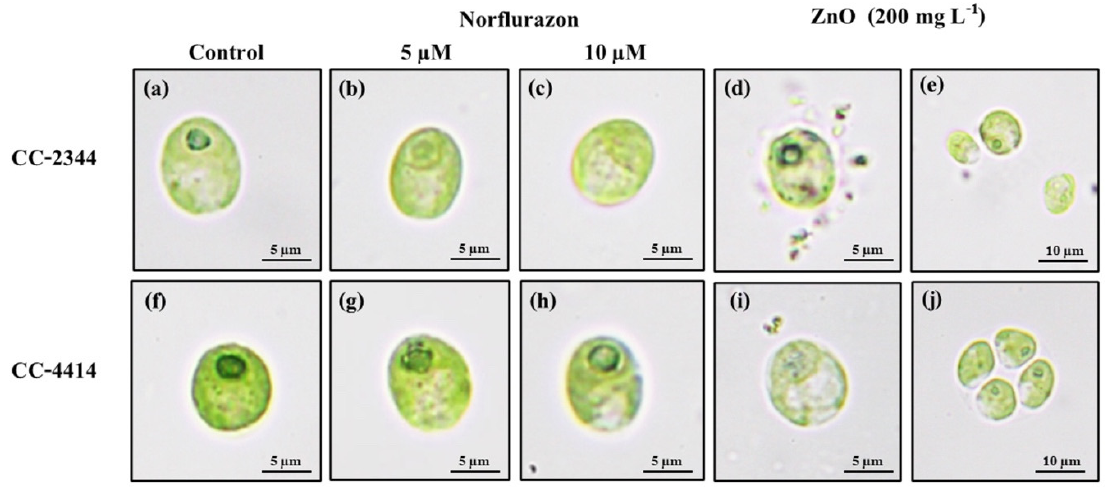
Figure 5. Morphological changes in cells exposed to norflurazon and ZnO NPs for 96 h. CC − 2344 and CC − 4414 were cultivated in TAP ( a , f ), TAP with norflurazon ( b , c , g , h ), and ZnO NPs ( d , e , i , j ).